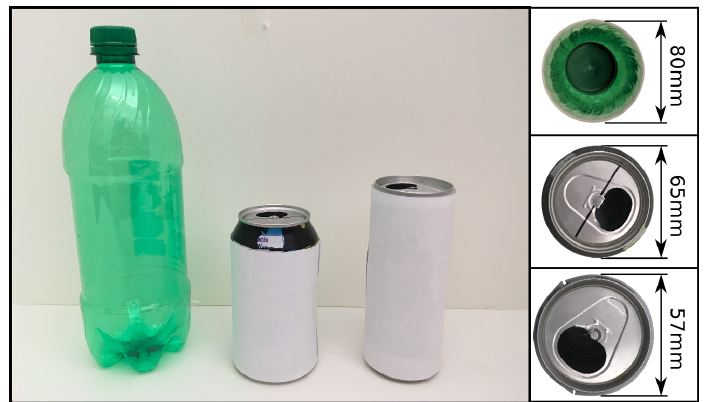
Figure 14. Object used during the first experiment.